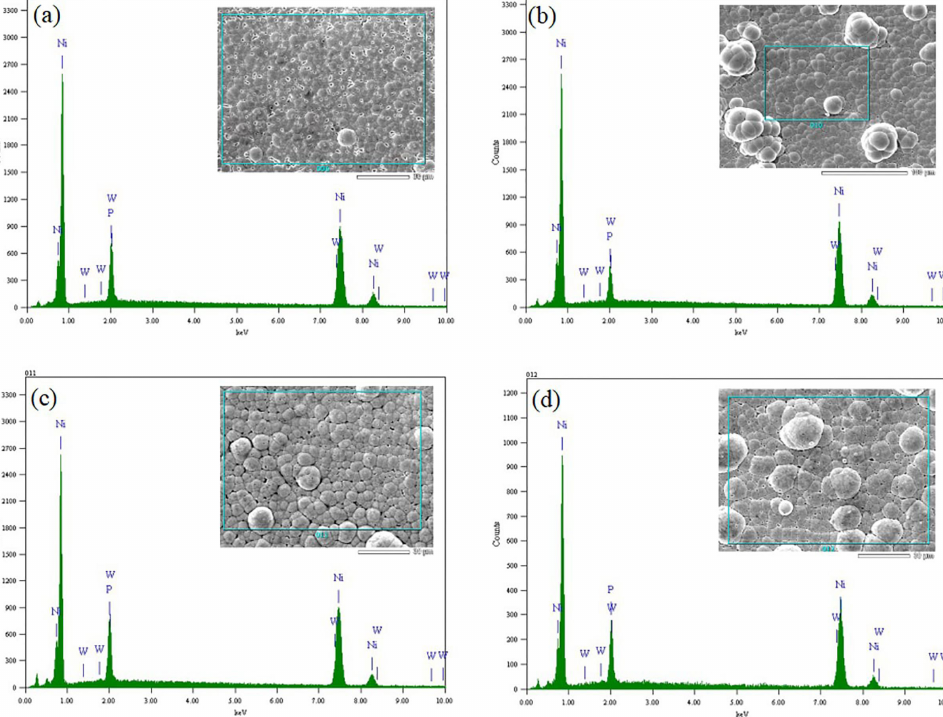
Figure 3. EDS of Ni-W-P coatings with different Na